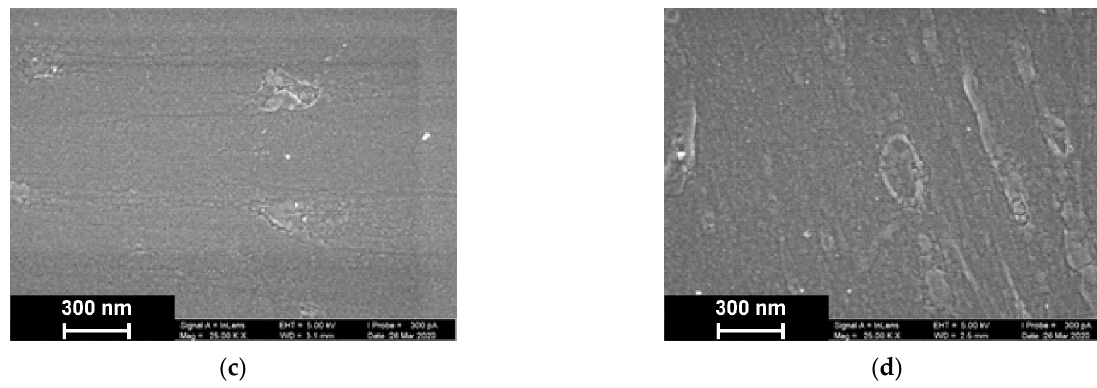
Figure 9. SEM images of the GCE surface covered with Azure A electropolymerized from phosphate buffer ( a , c ), in the presence of 0.2 mg/mL DNA ( b , d ), and in the absence ( a , b ) and presence of CHCl 3 ( c , d ). Twenty cycles of polymerization.